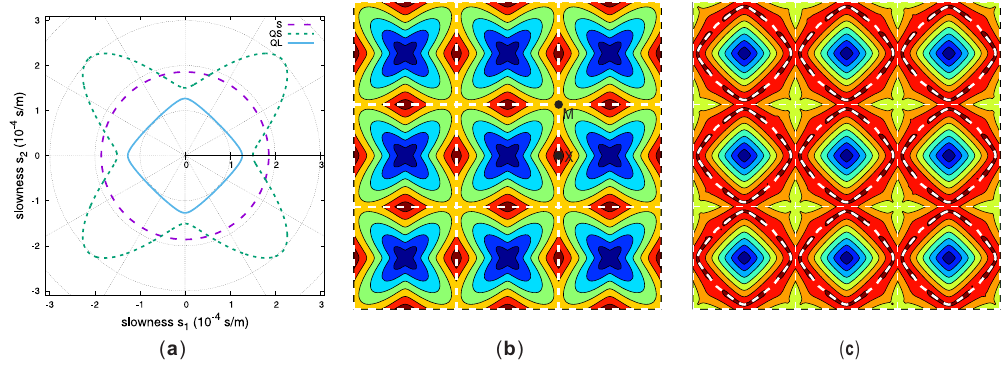
Figure 5. Empty lattice model for in-plane polarized waves in Z-cut rutile. ( a ) The three slowness curves are for a pure shear wave (long dashed line), a QS wave (short dashed line) and a QL wave (solid line). ( b ) Isofrequency curves are plotted for the first band of in-plane waves. The thick dashed lines represent the intersections between adjacent QS cones. ( c ) Isofrequency curves are plotted for the second band of in-plane waves. The thick dashed lines show the first intersection between QS and QL cones.